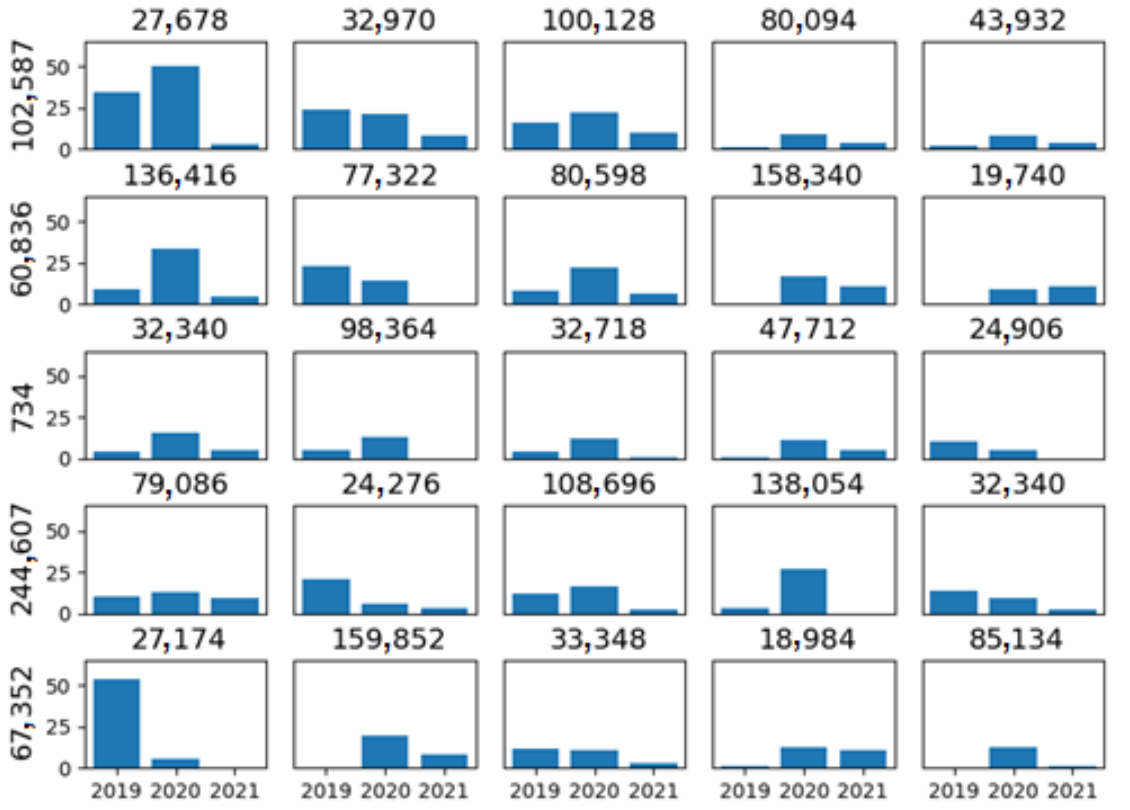
Figure 2. The number of orders ( y -axis) to the five preferred restaurants of the top five clients. Each row represents a client; the ID appears on the left. At the top of each graph is the restaurant ID. The three bars represent the number of orders for 2019, 2020, and 2021.